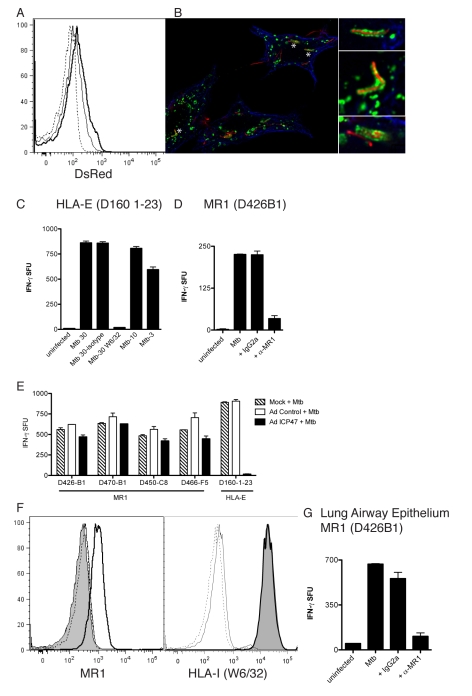
Characterization of MR1-dependent recognition of human lung epithelial cells.(A) Flow cytometric analysis of A549 cells left uninfected (dashed line) or infected with Mtb H37Rv dsRED at an moi of 10 (solid line) or an moi of 30 (bold line). (B) A549 cells were infected with Mtb (dsRED-expressing H37Rv moi of 30∶1) and incubated overnight. Cells were washed, fixed (4% paraformaldehyde), and permeabilized (0.2% saponin) before being stained for expression of Lamp1 (green) and tubulin (blue). Images were acquired on a high-resolution wide-field Core DV system (Applied Precision) with a Nikon Coolsnap ES2 HQ. One 0.5-µm Z-section is shown. Asterisks indicate magnified regions. (C) A549 cells uninfected or infected with Mtb over a range and at the moi of 30 in the presence of anti-pan HLA-I blocking antibody (W6/32) or the IgG2a isotype control (2 µg/ml each) before being used as APCs for HLA-E–restricted T-cell clone D160 1–23 in the IFN-γ ELISPOT assay. (D) A549 cells uninfected or infected with Mtb (moi 30) were used as APCs for T-cell clone D426B1 in the presence of anti-MR1 blocking antibody or the IgG2a isotype control (2 µg/ml each) in the IFN-γ ELISPOT assay. Similar results were obtained from four different MR1-restricted T-cell clones. (E) A549 cells were infected with either control vector or adenoviral ICP47. After 16 h, A549 cells were washed and left uninfected or were infected with Mtb (moi 30). Following overnight incubation, T cells were added (10,000) and IFN-γ production was assessed by ELISPOT. Results are representative of three independent assays. Error bars represent the mean and standard error from duplicate wells. (F) Flow cytometric analysis of A549 cells that were left uninfected or infected with Mtb (moi of 30). The filled histogram represents cell surface MR1 (left panel) or HLA-I (right panel) staining on uninfected cells. All lines represent cell surface staining performed on Mtb-infected A549 cells (moi 30). Dashed line, Alexa 647 secondary control; solid line, msIgG2a isotype control; bold line, cell-surface staining of MR1 (26.5)(left panel) [28], or HLA-I (W6/32) (right panel). Cell surface expression of HLA-I is identical on uninfected and infected A549 cells. (G) Human primary large airway epithelial cells were infected with Mtb (moi 30) and used as APCs (25,000/well) for MR1-restricted T-cell clone D426B1 (15,000/well) in the IFN-γ ELISPOT assay in the presence of no, anti-MR1 (26.5) or IgG2a isotype control antibodies (2 µg/ml final each). Similar results were obtained in three independent experiments.